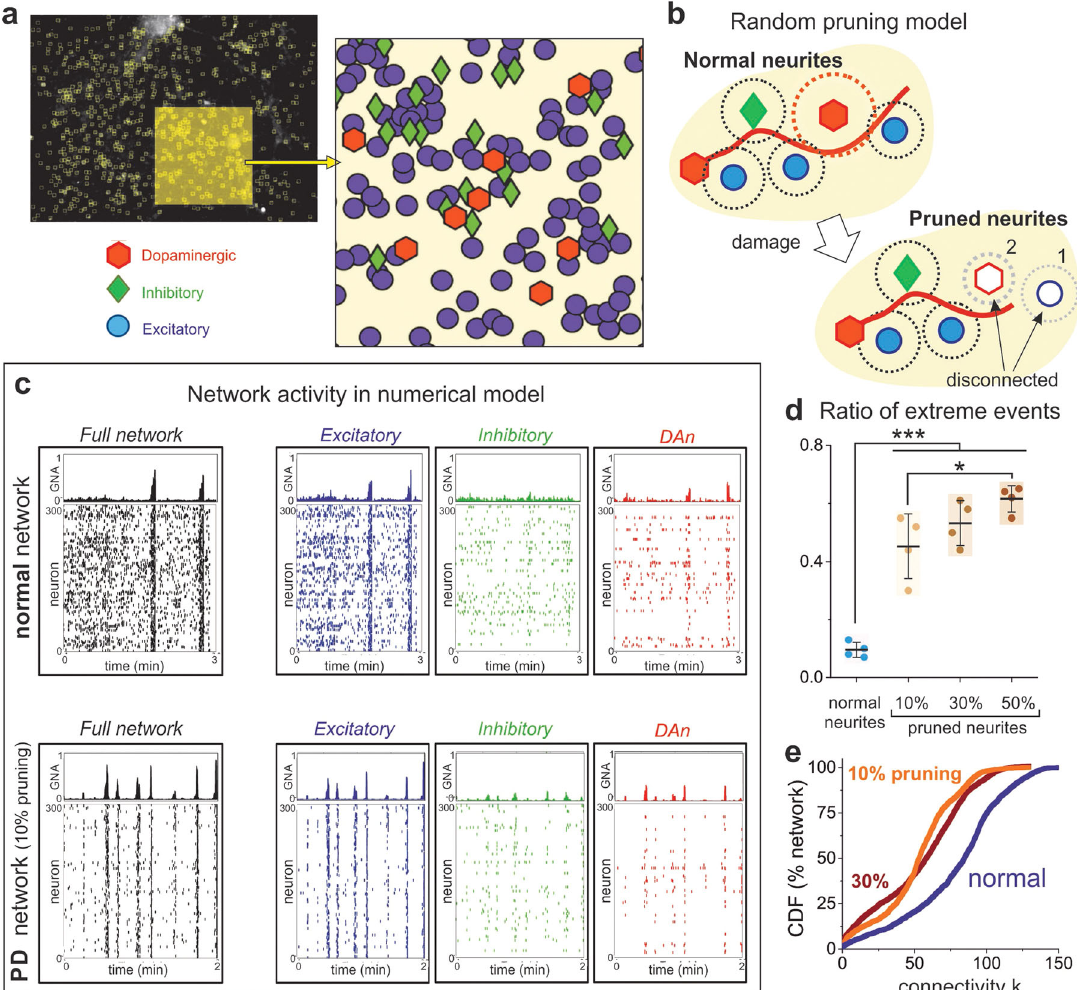
Fig. 5 Numerical simulations of normal and PD networks. a Representative CTR culture at day 80, used as a reference for the spatial allocation of neurons in the numerical model. The enlarged area depicts a detail of the neuronal spatial arrangement. 300 neurons are used in the simulation, and are randomly assigned as dopaminergic (DA, red, 25% of network), inhibitory (green, 20%), and excitatory (blue, 55%). b Random pruning algorithm, in which PD damage is simulated by a shortening of either axons (red curve) or dendritic arbor (dotted red circle) in DA neurons (red hexagons). In the sketch, normal connectivity is established when the dendritic arbor of any neuron (dotted circles) intersects an axon. Neurite pruning disconnects neurons either because of axonal shortening (neuron #1) or dendritic loss (neuron #2) in DAn. c Raster plots of simulated normal and PD networks, with the latter corresponding to an axonal pruning on 10% of DA neurons, each one losing about 80% of connections. In the raster plots, the left panels show the dynamics of the entire network, whereas the right panels show the dynamics in each subpopulation. All raster plots range from 0 to 300, but the number of active neurons in each plot vary according to the population monitored. PD simulations show a markedly synchronous behavior of the excitatory population that translates onto the entire network. d Ratio of extreme events for different percentages of pruned DAn subpopulation, showing that the presence of extreme bursting events increases as network affectation progresses. The colored boxes are a guide to visualize the distributions, which show the mean ± SD and the individual realizations (dots). The number of individual simulations is n = 4 for each condition. *** p < 0.001; * p < 0.05 (ANOVA with multiple comparison analysis). e Cumulative distribution of functional connections (CDF) for two PD networks (at 10 and 30% pruning) and a normal, non-pruned network. The distributions show the same trend as in the experiments, with PD departing from normal toward a low degree functional connectivity